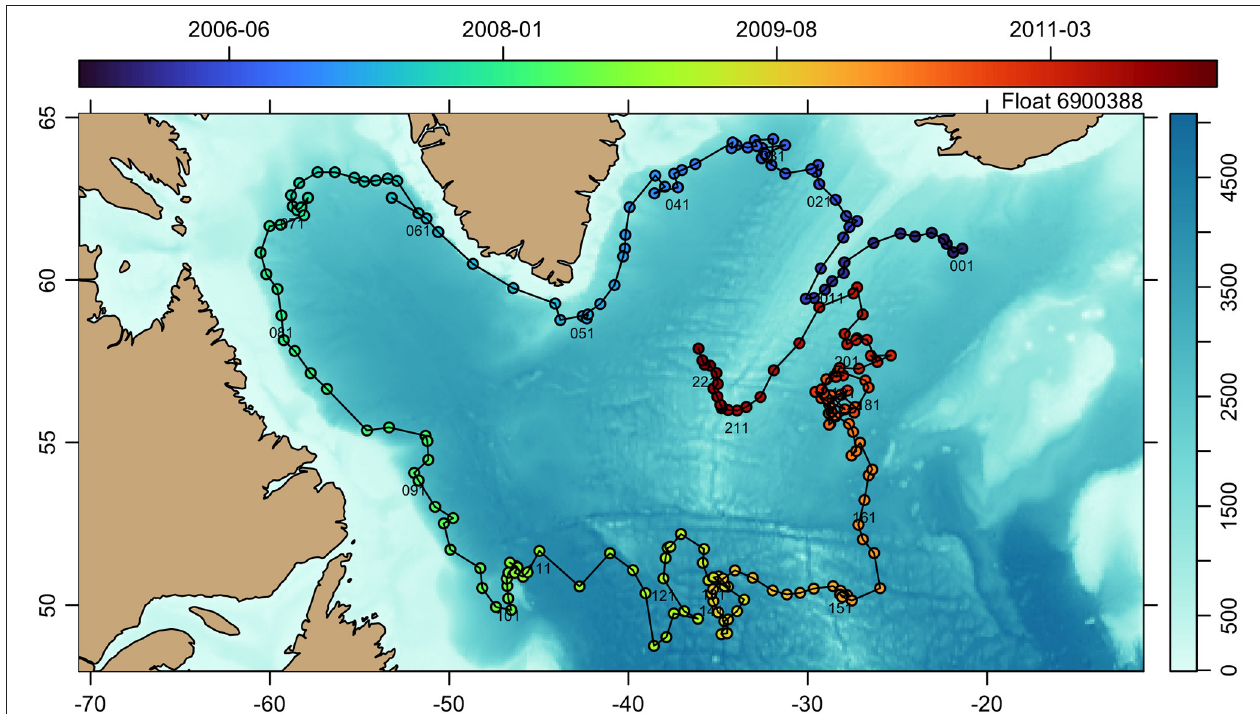
FIGURE 4 | Trajectory of Argo float 6900388 circulating in the northwest Atlantic Ocean. Water depth is indicated in the color underlay, and sampling time is indicated with colored dots. Cycle numbers are labeled at regular intervals, indicating that this float made well over 200 cycles during its 5-year lifetime.